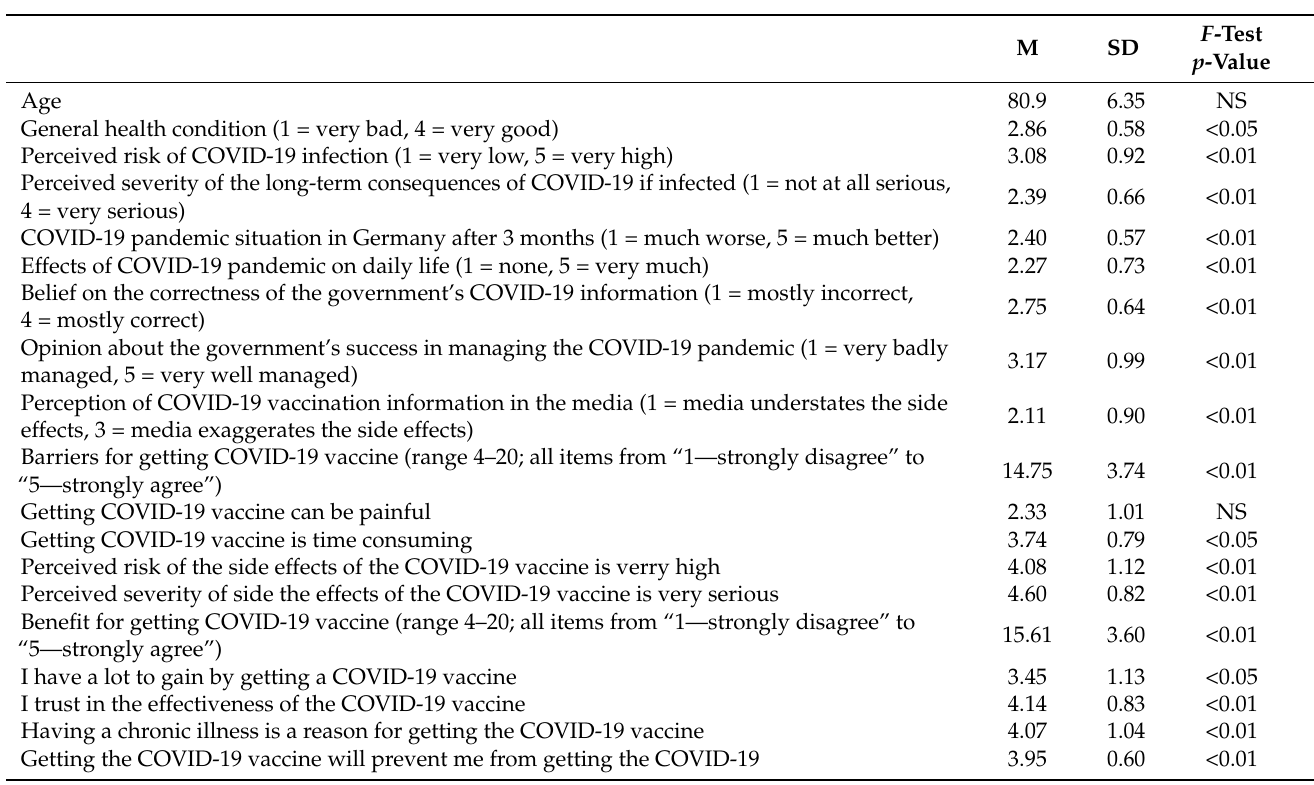
Table 2. Descriptive statistics for the study variables and F -test statistics for intention to get vaccinated if offered (three